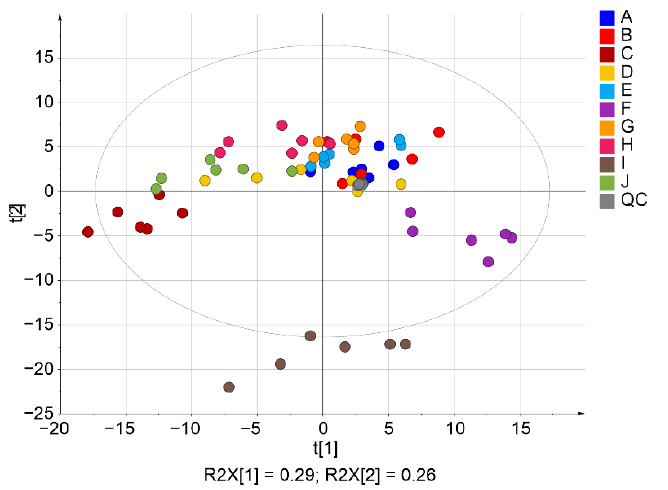
Figure 5. Hierarchical cluster analysis of lnPQN transformed data. Colors represent 10 individuals (A–J) who were sam- pled from the left (L) and right (R) sides for 3 different days (1–3).